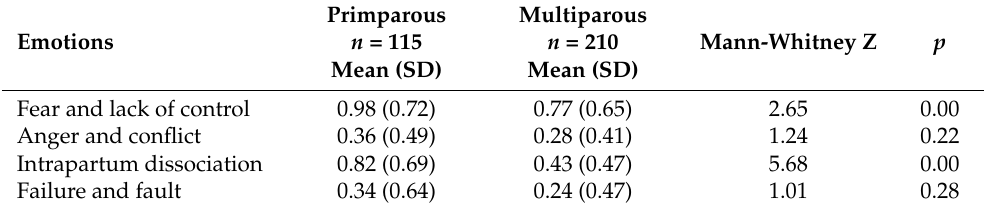
Table 2. Differences in emotions based on primiparous and multiparous groups.